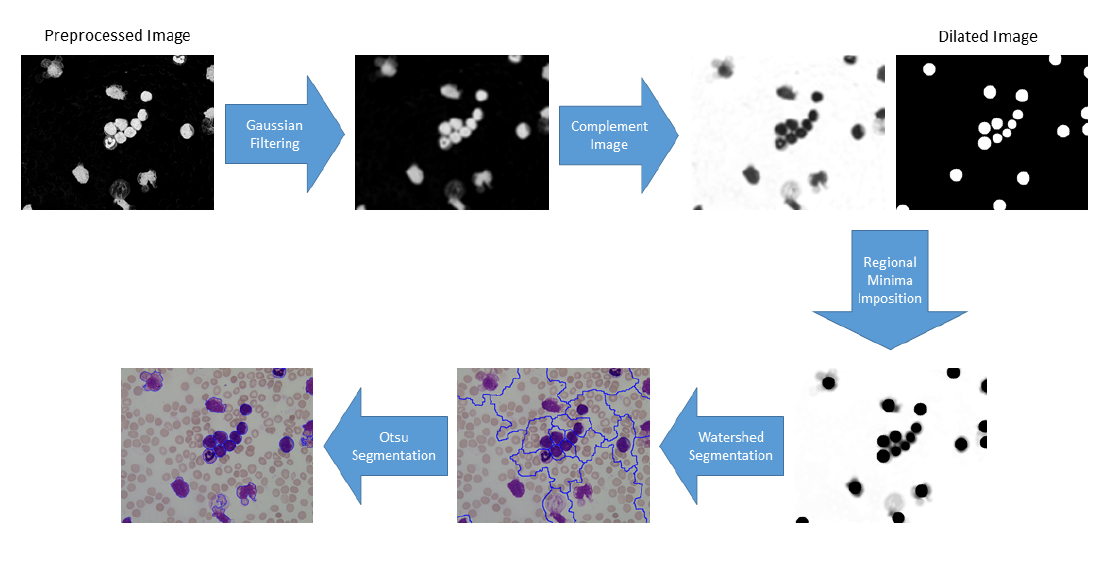
Figure 7. The overall scheme of the image segmentation